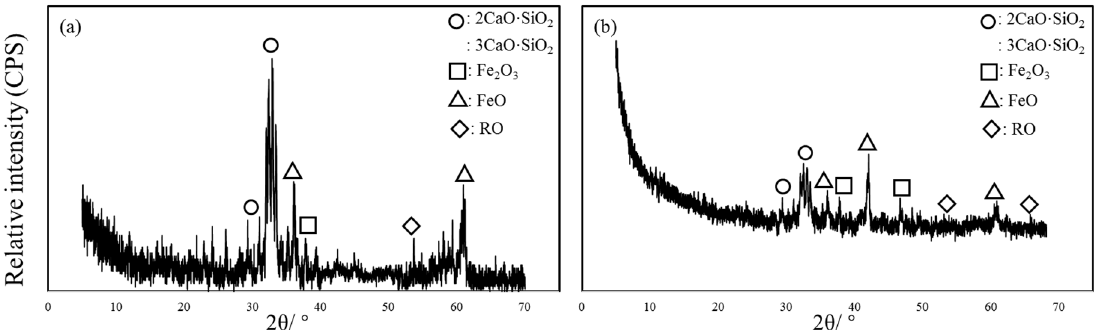
Figure 5. Phases of two kinds of slag: ( a ) BOF slag, ( b ) FER slag.